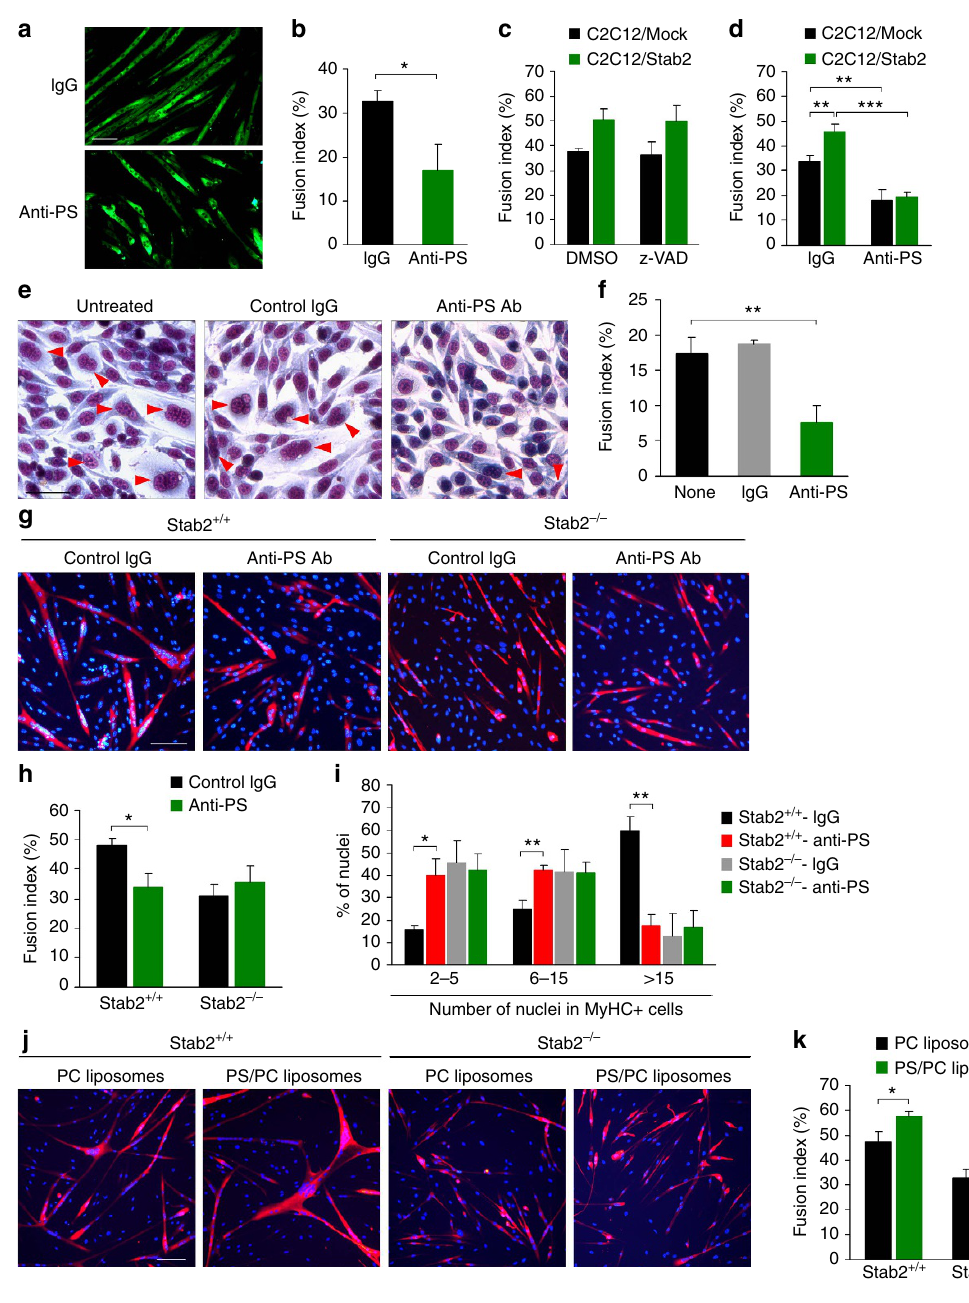
Figure 7 | Stabilin-2 contributes to phosphatidylserine-dependent myoblast fusion. ( a , b ) C2C12 cells were incubated with differentiation medium for 5 days in the presence of anti-PS antibody or isotype-matched IgG. Representative images ( a ) are shown. Scale bars, 100 m m. Fusion indices ( b ) were calculated. Data are presented as mean ± s.d. ( n ¼ 3). ( c ) The fusion indices of C2C12/Mock and C2C12/Stab2 cells in the presence of pan-caspase inhibitor (z-VAD-fmk, 30 m M) or DMSO were calculated at DM5 ( n ¼ 3). ( d ) The fusion indices of C2C12/Mock and C2C12/Stab2 cells in the presence of anti-PS antibody (10 m gml (cid:2) 1 ) or isotype-matched IgG (10 m gml (cid:2) 1 ) were calculated at DM5 ( n ¼ 4). ( e , f ) L/Stab2 cells were incubated with fusion medium for 48h in the presence of anti-PS antibody or isotype-matched IgG. Representative images ( e ) are shown. Red arrowheads indicate multinucleated cells. Scale bars, 100 m m. Fusion indices ( f ) were calculated. Data are presented as mean ± s.d. ( n ¼ 3). ( g ) Stab2 þ / þ and Stab2 (cid:2) / (cid:2) myoblasts were induced to differentiate in the presence of anti-PS antibody or isotype-matched IgG. After 48h, cells were stained with anti-MyHC antibody. Representative microscopic fields are shown. Scale bars, 100 m m. ( h ) At DM2, the fusion indices of Stab2 þ / þ and Stab2 (cid:2) / (cid:2) myoblasts in the presence of anti-PS antibody or isotype-matched IgG were calculated. Data are presented as mean ± s.d. ( n ¼ 3). ( i ) Stab2 þ / þ and Stab2 (cid:2) / (cid:2) myoblasts were fixed and immunostained for MyHC after 2 days of differentiation (DM2), and the percentage of nuclei present in MyHC-positive cells with the indicated number of nuclei were calculated. Data are presented as mean ± s.d. ( n ¼ 3). ( j ) Stab2 þ / þ and Stab2 (cid:2) / (cid:2) myoblasts were induced